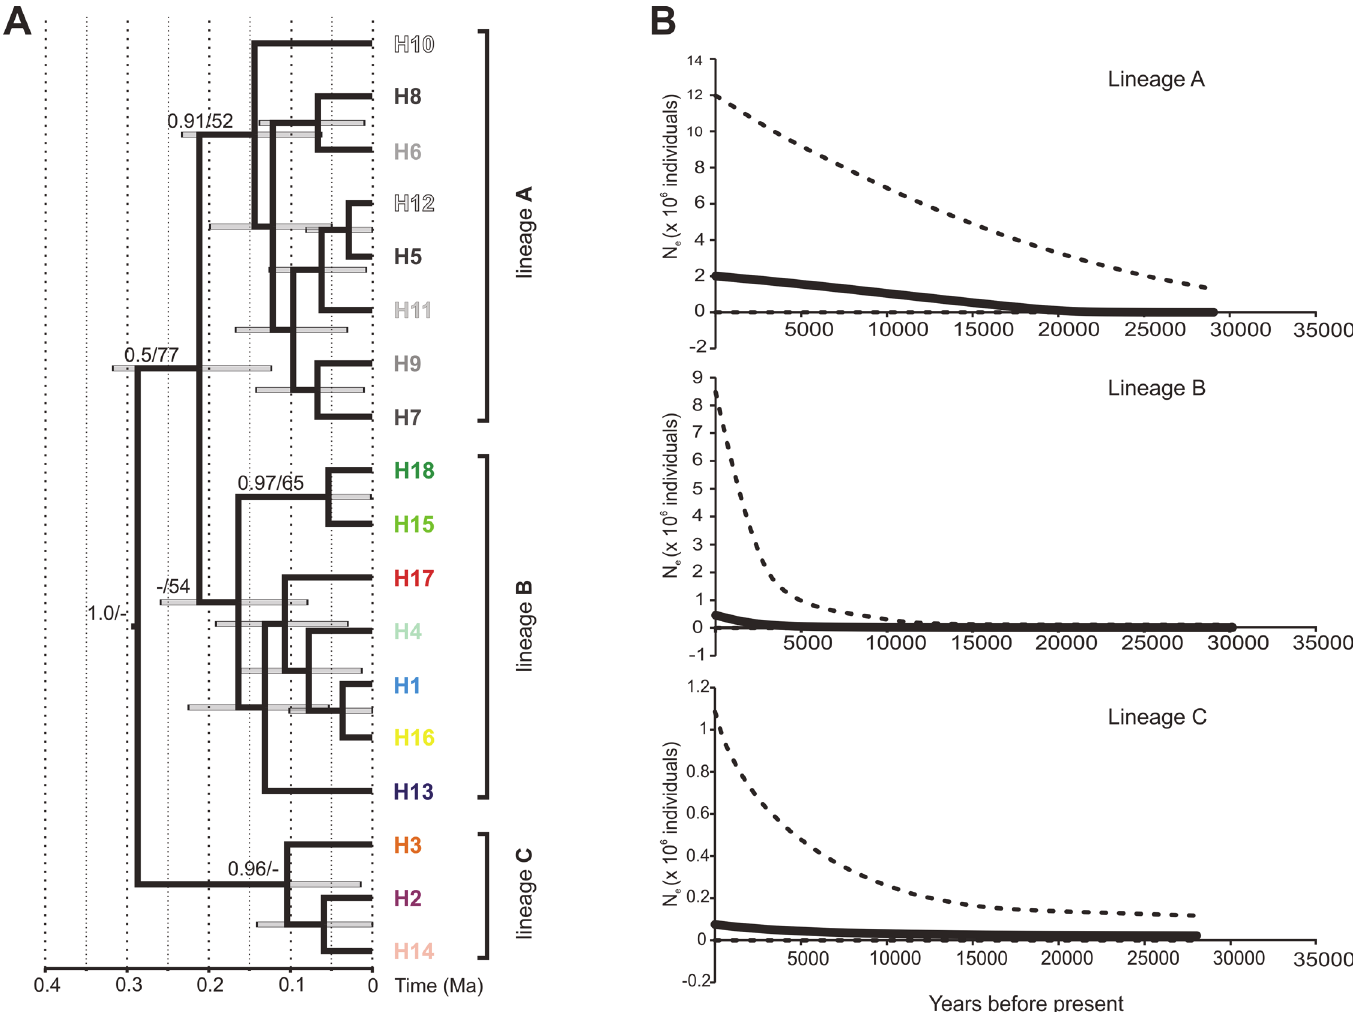
Fig 3. Phylogeny and demographic history of D. villosus in the native Black Sea area. (A) Maximum clade credibility chronogram inferred from a strict molecular clock model based on the concatenated COI+16S data set of Dikerogammarus villosus . The two numbers given next to the respective node indicate Bayesian posterior probabilities ( > 0.5), and maximum likelihood bootstrap values ( > 50%). (B) Multilocus extended Bayesian skyline plots for three linages of Dikerogammarus villosus . Solid lines indicate the median posterior effective population size through time; dashed lines indicate the 95% highest posterior density interval for each